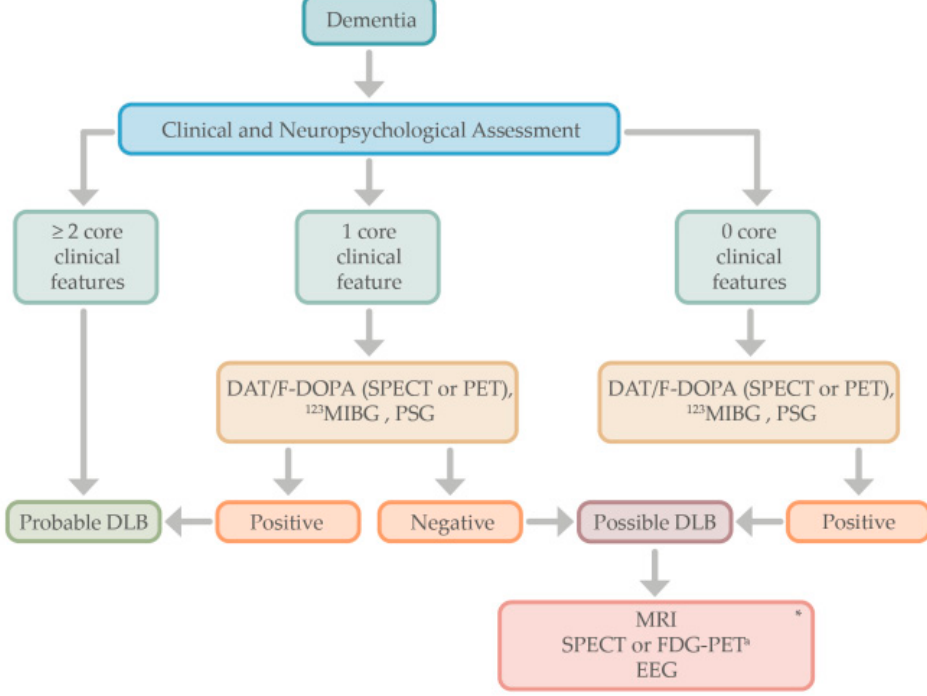
Figure 2. Proposed algorithm for the diagnostic approach in Lewy body dementia. * Supportive biomarkers that help in the diagnostic evaluation but without clear diagnostic specificity. a The cingulate island sign is only identifiable in FDG-PET, not in SPECT. DLB, dementia with Lewy bodies; DAT; dopamine transporter; F-DOPA, Flurodopa PET; SPECT, single photon emission computed tomography; PET, positron emission tomography; MIBG, iodine-123 –metaiodobenzylguanidine; PSG, polysomnography; MRI, magnetic resonance imaging; FDG-PET, fluoro-deoxy-glucose PET; EEG, electroencephalogram.